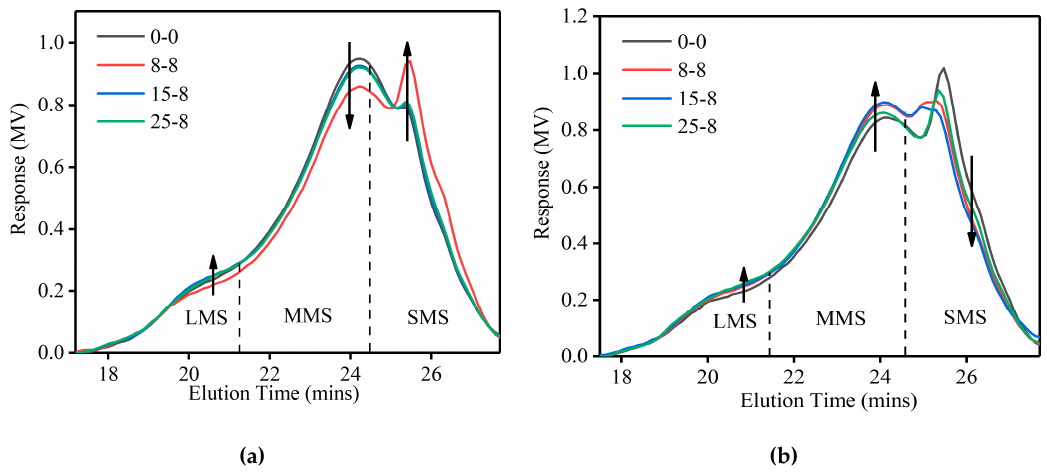
Figure 9. GPC curves of mastics in different test conditions. ( a ) Base mastics; ( b ) SBS-modified mastics. Note: LMS—large molecular size, MMS—medium molecular size, and SMS—small molecular size ratios.